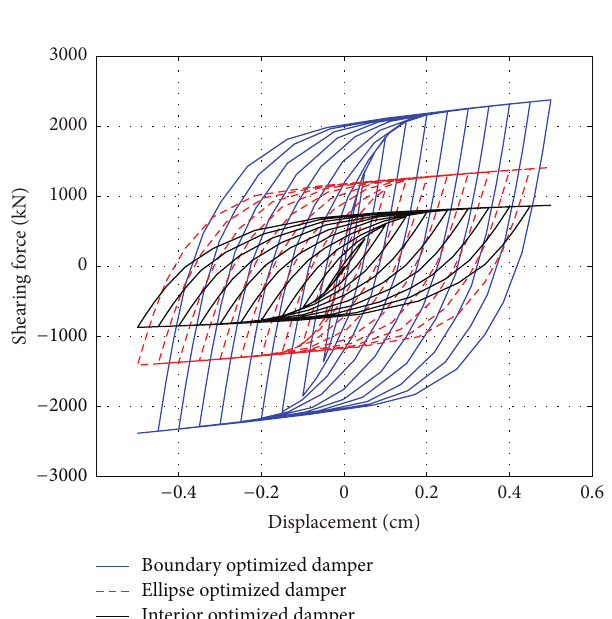
Figure 14: Comparison of hysteresis